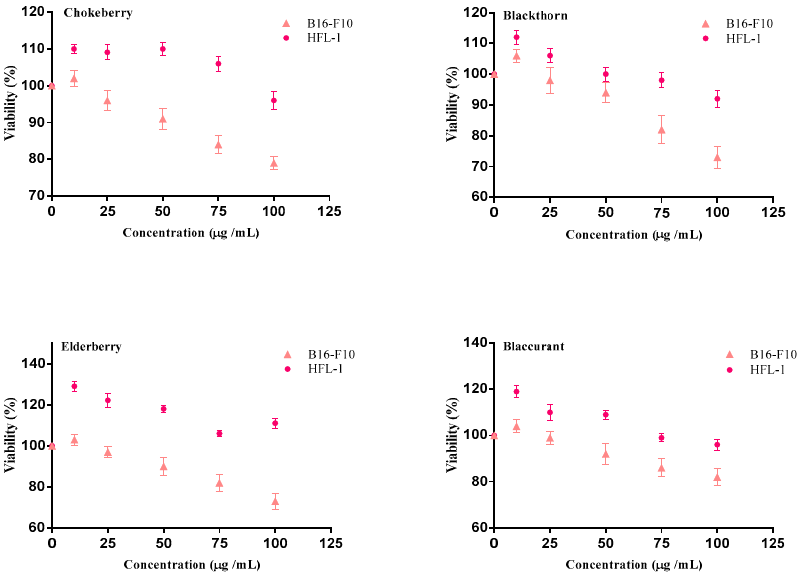
Figure 13. Effect of RPE from chokeberry, blackthorn, elderberry and blackcurrant on B16-F10 and HFL-1 cell proliferation.